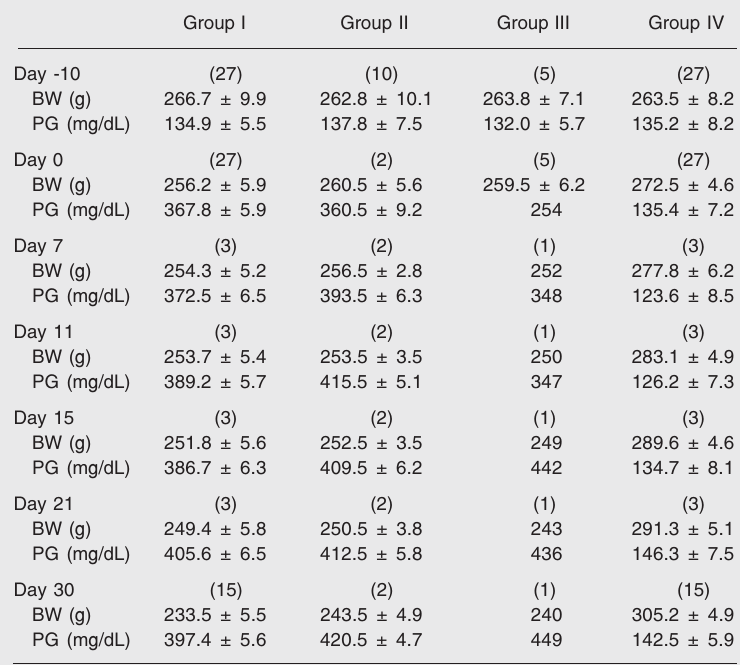
Table 1. Body weights and plasma glucose levels of the experimental